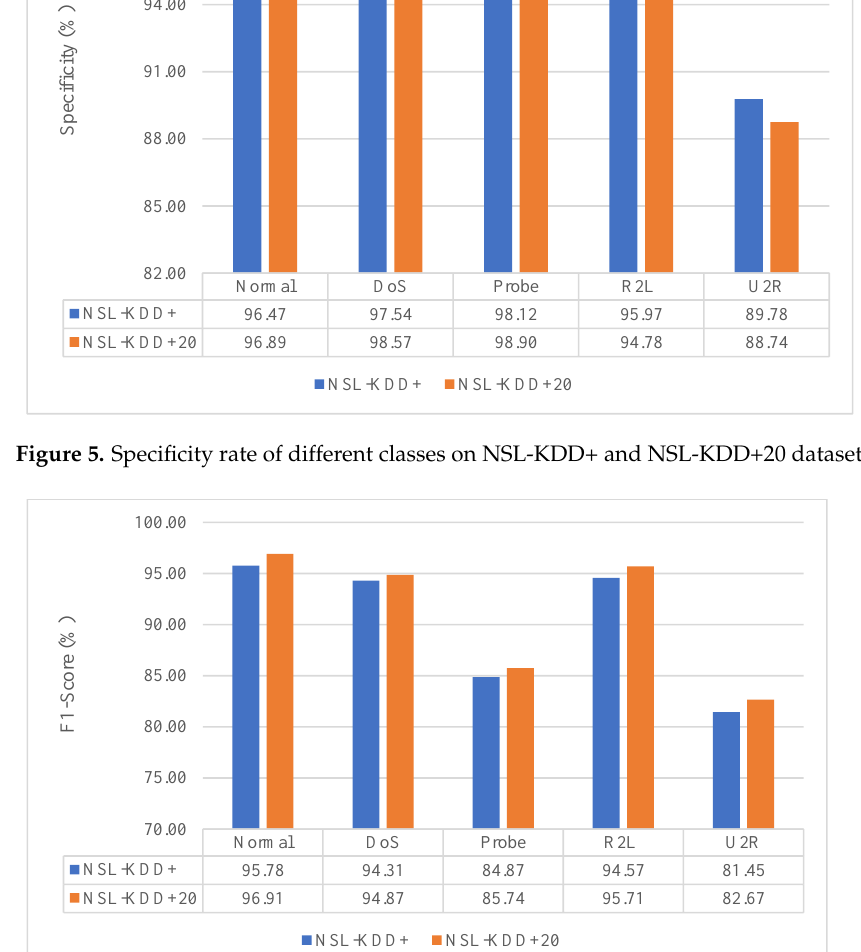
Figure 6. F1-score of different classes on NSL-KDD+ and NSL-KDD+20 datasets.